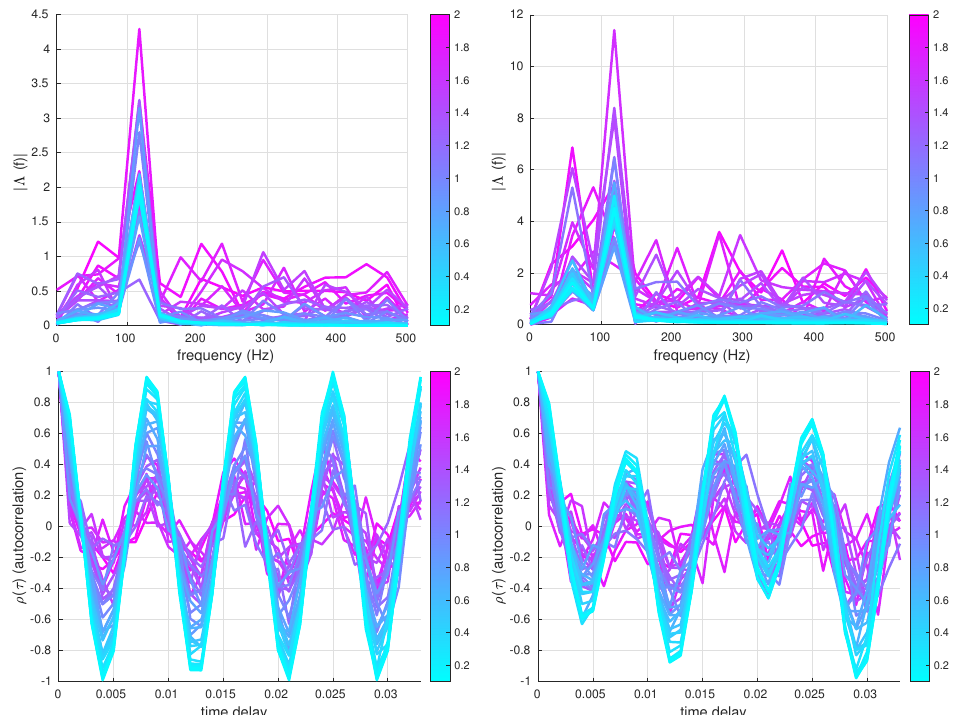
Figure 3. Graphs to highlight the efficacy of a power spectrum and autocorrelation to detect under- lying frequencies. The top graphs are power spectra, while bottom graphs are the autocorrelation function for the two signals in Figure 2. The colour bar on the right is the proportion of noise to signal, λ i